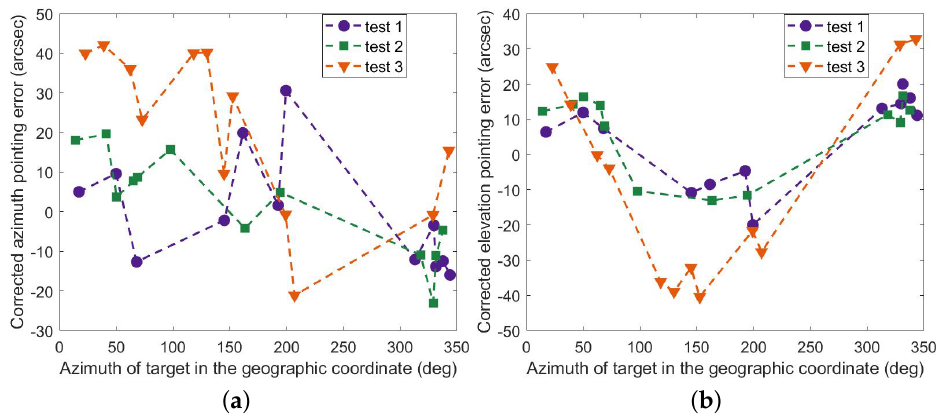
Figure 13. Residual errors of OPM ( a ) in azimuth and ( b ) in elevation.